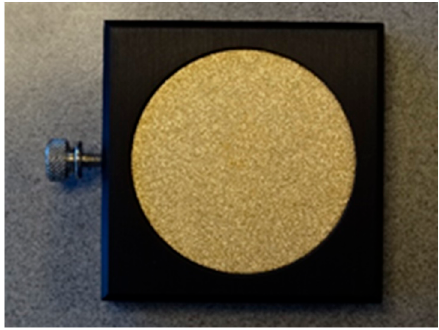
Figure A10. ( a ) Direct and ( b ) tilted beams for the compensation of the sphere substitution error at ONERA.